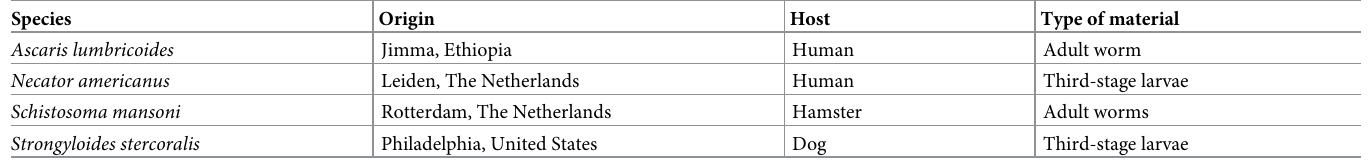
Table 2. Origin and type of worm material used for the HEMQAS